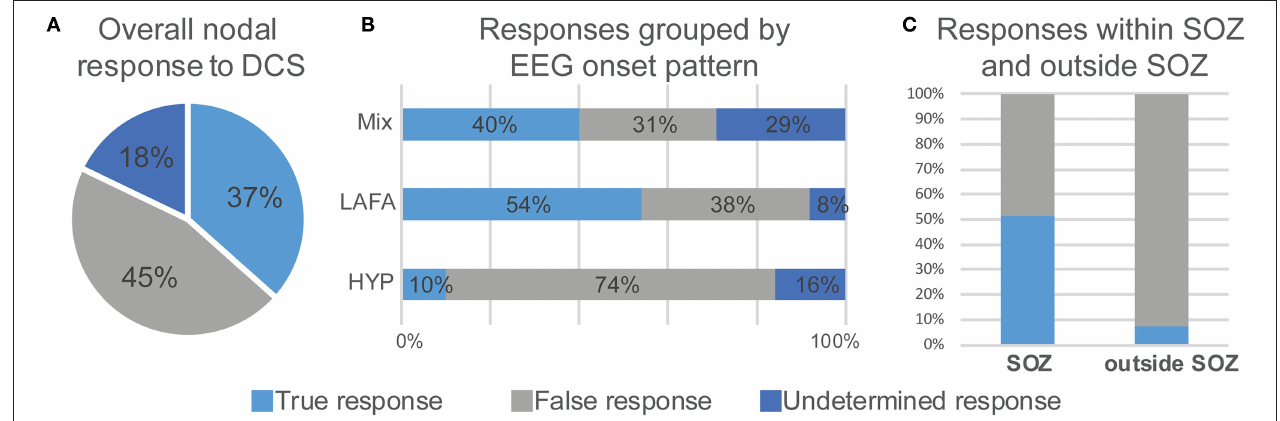
FIGURE 3 | Electroclinical responses to direct cortical stimulation (DCS) of nodes with high epileptogenicity index (EI > 0.3). Overall nodal responses (A) and distribution of responses as a function of seizure onset pattern (B) and colocalization with seizure onset zone (C) . LAFA = low amplitude fast activity. HYP, hypersynchronous onset; SOZ, seizure onset